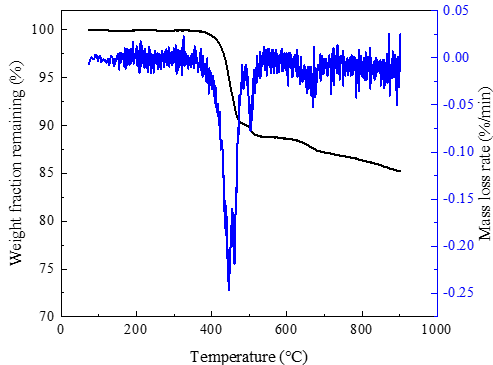
Figure 5. Thermogravimetric (TG) and differential thermogravimetric (DTG) curves of Xinjiang oil